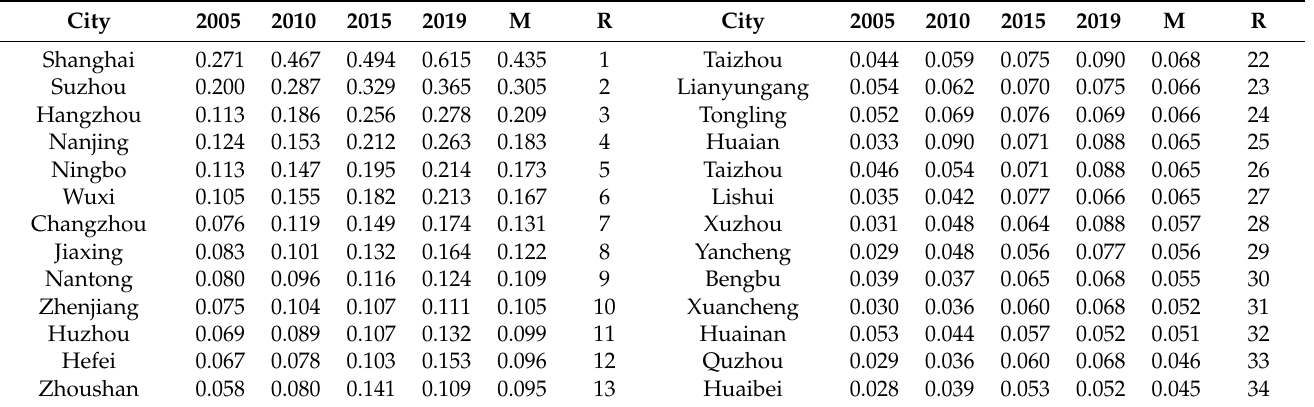
Table 3. The development level of the Open Economy in YRDA from 2005 to